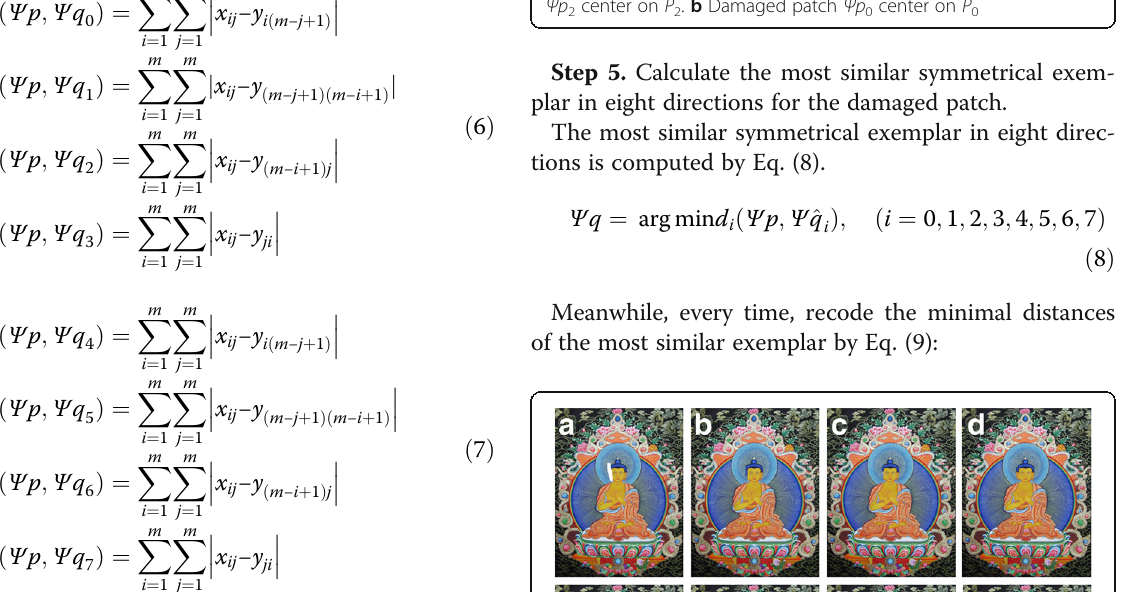
Ψ p P 0 center on 0